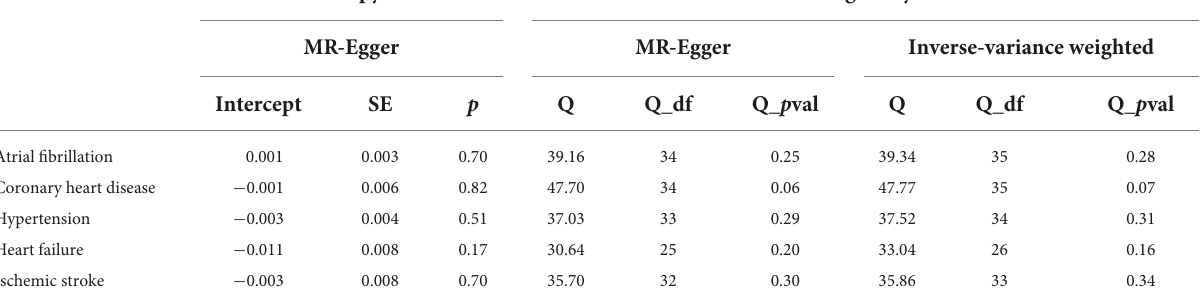
TABLE 2 Pleiotropy and heterogeneity test of the tea intake from CVD GWAS. Outcomes Pleiotropy test Heterogeneity test MR-Egger MR-Egger Inverse-variance weighted